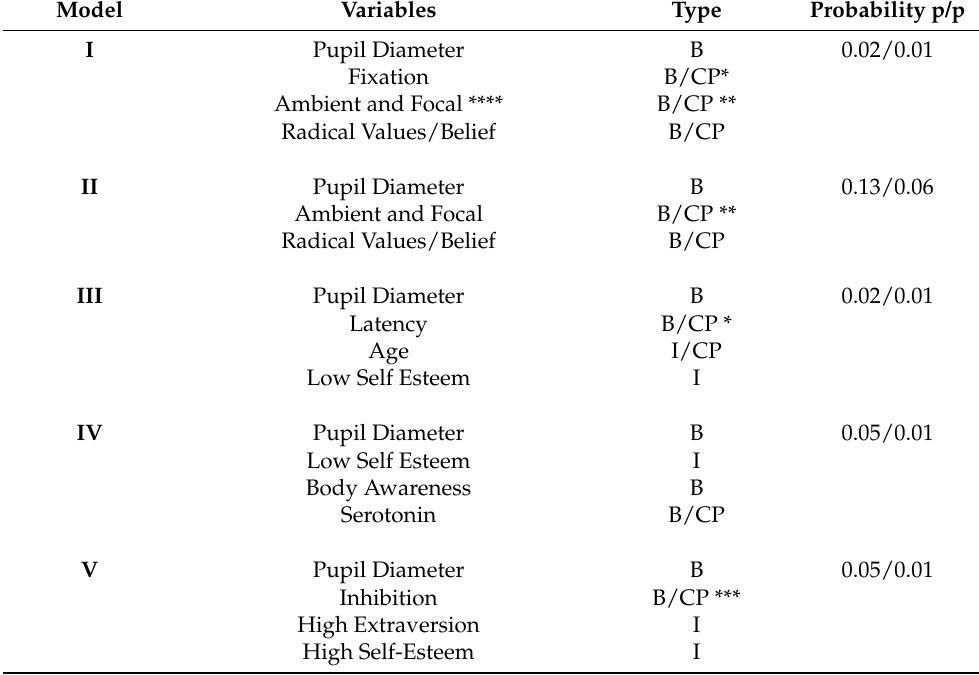
Table 2. Results from SPARQL queries for model I–V. *, e.g., related to a blank stare ** change sexual and pre-motoric *** indirect through relationship between inhibition and overcontrol **** focal and ambient are two different variables (counted as 1 or 0). I = Individual characteristic, B = Behavior/Brain processing/Biochemistry and CP = Criminal Profiles. Probability column